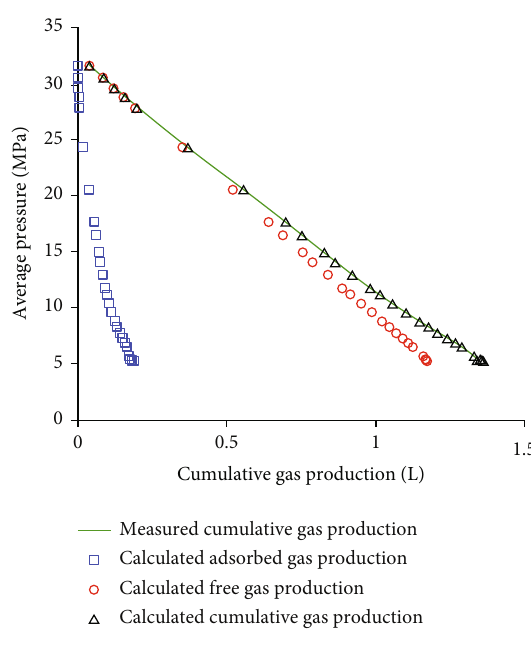
Figure 8: The relationship between the calculated gas production and apparent